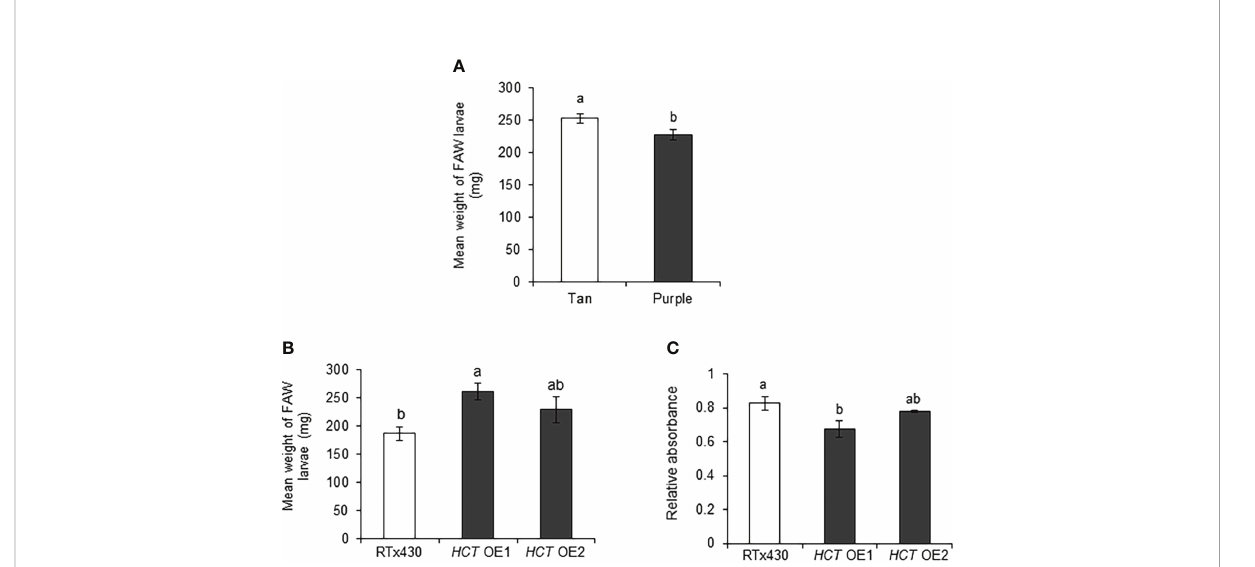
FIGURE 7 Sorghum fl avonoids affected the fall armyworm (FAW) growth adversely. Mean larval weight of FAW collected from (A) sorghum tan and purple lines (n = 11-15 for each sibling line, total n = 63-79), and (B) RTx430 (wild-type) and HCT ( p -hydroxycinnamoyltransferase)-overexpression (OE) events (n = 19-21), 10 days after the introduction of newly hatched larvae on sorghum (three-leaf stage) plants under greenhouse conditions. (C) Total fl avonoids estimated using spectrophotometer on two-week-old RTx430 and HCT OE plants (n = 3-4). Error bars represent ± SE. Different letters indicate signi fi cant difference relative to each other ( P < 0.05).